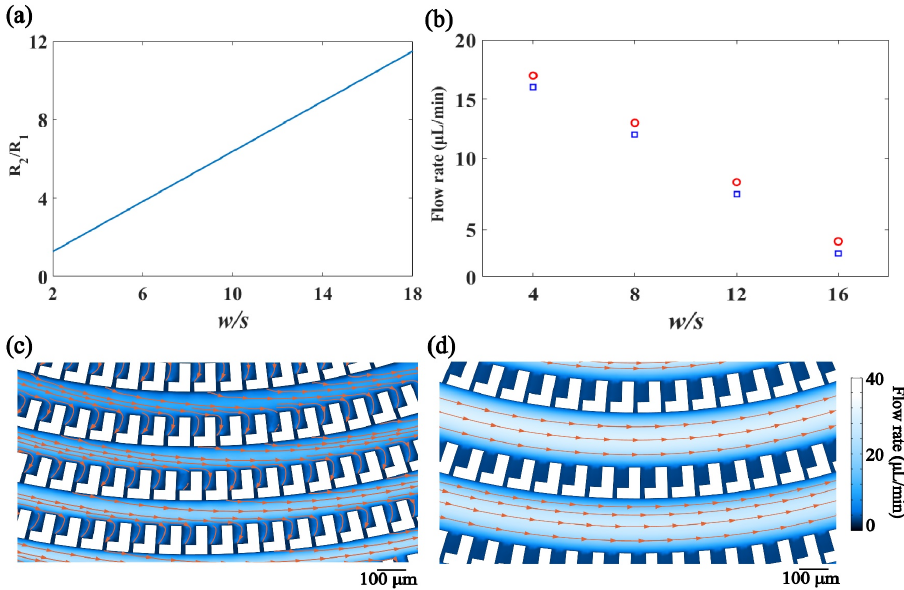
Figure 6. ( a ) The influence of the ratio between the size of the main channel and the gap, i.e., w/s , over the ratio between the hydraulic resistance in the trap and the main channel. ( b ) The flow rate through the traps for different values of w/s . Red circle: the trap close to the center of the spiral. Blue square: the trap close to the edge of the spiral. ( c ) Simulation of the flow in the microfluidic structure when w/s is 8. ( d ) Simulation of the flow in the microfluidic structure when w/s is 16.